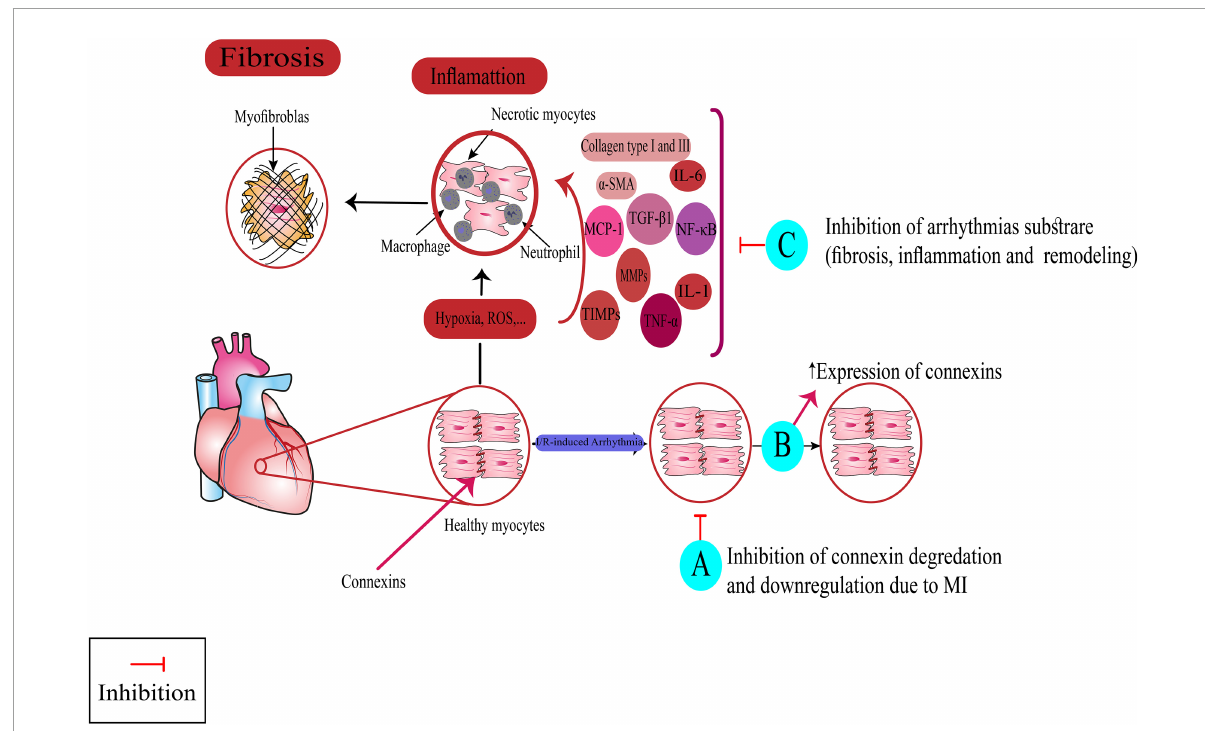
FIGURE4 Targeting non-ionic mechanism for suppressing arrhythmias by medicinal plants, multi-component herbal preparations, and phytochemicals. Some of them have more than one mechanism. Class (VI): A: Nardostachys chinensis , Linalool, B: Danqi soft capsule, Fumai granule, Tongguan capsule, Grape seed proanthocyanidin. Class (VII): C: Arnebiae euchroma, Rhodiola spp., Danqi soft capsule, Ping-Lv-Mixture, Shensong Yangxin capsule, Fumai granule, Bilberry Anthocyanins, Hesperidin, Troxerutin, Magnolol, Panax notoginseng saponins, Arctigenin, Yindanxinnaotong capsule. Nrf2: Nuclear factor erythroid 2-related factor 2, TGF- β 1: transforming growth factor-beta1, MCP-1: monocyte chemoattractant protein-1, TNF- α : tumor necrosis factor- α : TNF- α , TIMPs: Tissue inhibitors of metalloproteinases, MMPs: Matrix metalloproteinases,